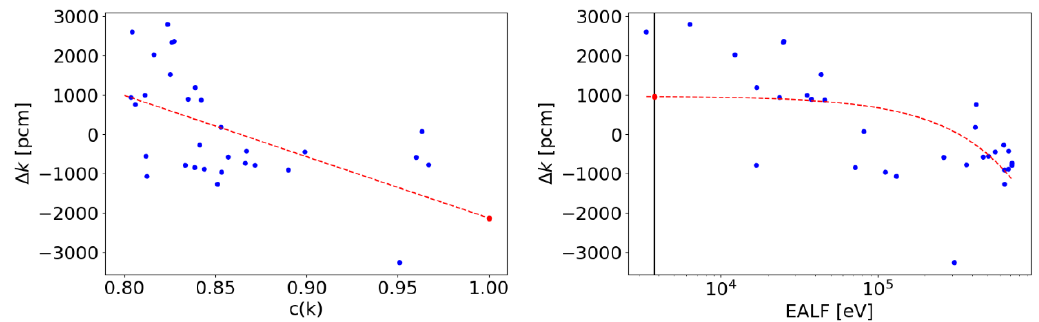
Figures 4e and 4f. The updated error between the model and the corresponding experiment as a function of c